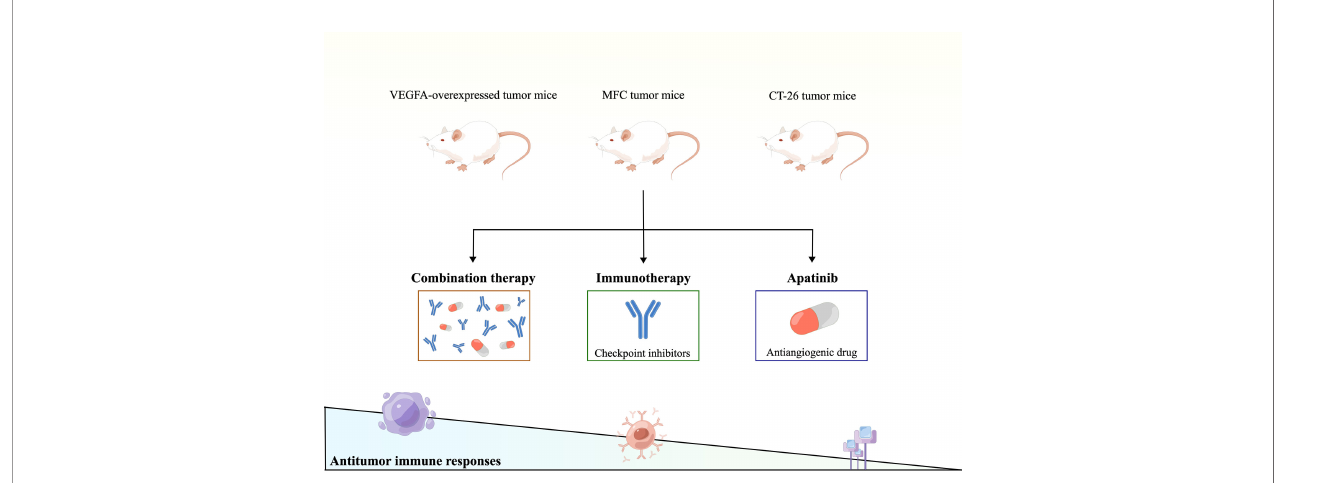
FIGURE 2 | Therapeutic strategies of apatinib combined with immune checkpoint inhibitors to match the expanding gradient of systemic therapeutic